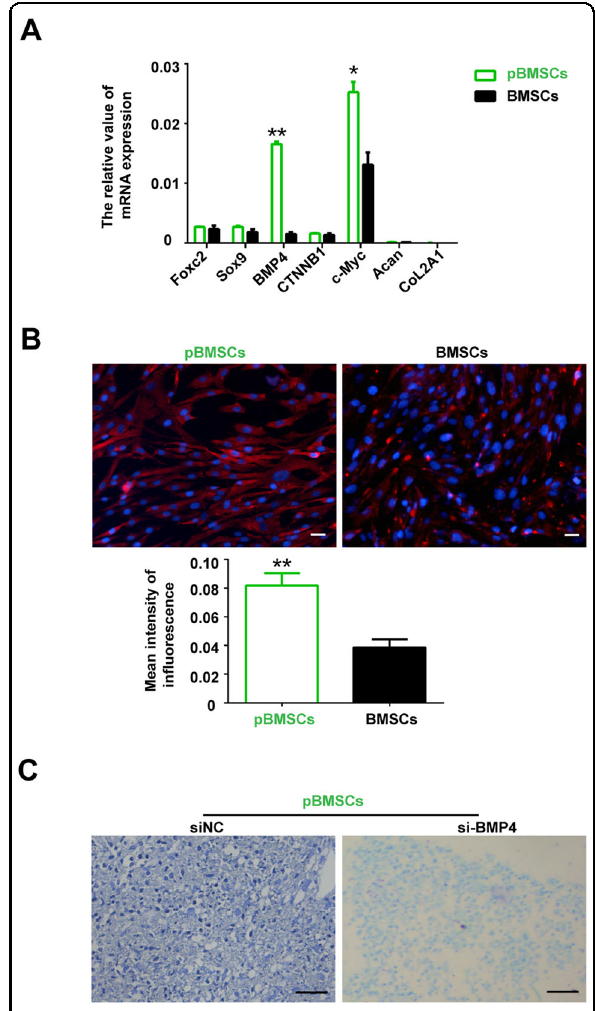
Fig. 3 Effects of BMP4 on the pBMSCs differentiated into chondrocytes. A The mRNA expression of Foxc2, Sox9, BMP4, CTNNB1, c-Myc, Acan, CoL2A1, and actin was analyzed by qRT-PCR. B BMP4 (red) and DAPI (blue) IF staining of pBMSCs and BMSCs. Scale bars, 40 μ m. C pBMSCs were induced to differentiate into chondrocytes after BMP4 knockdown. Scale bars, 40 μ m. In addition, there was a signi fi cant difference between the BMSCs and pBMSCs groups, * P < 0.05, ** P <